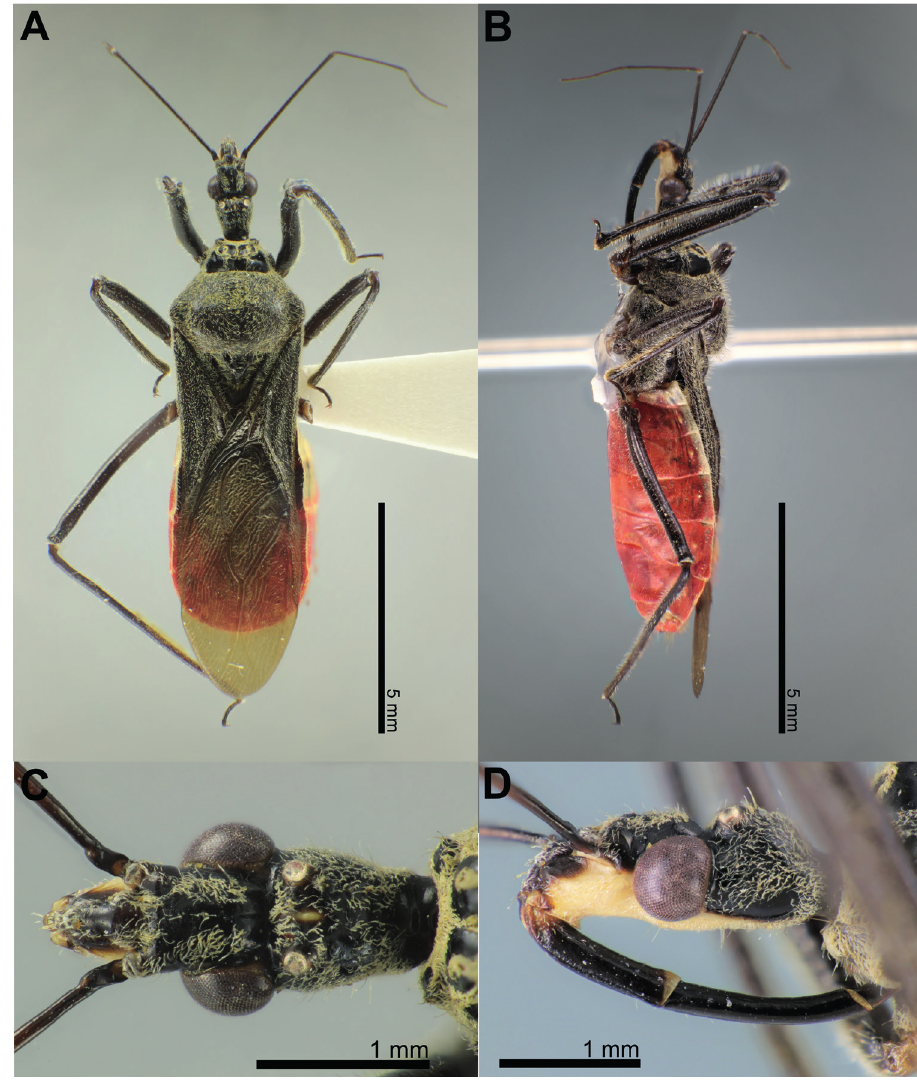
Figure 13. Biasticus taynguyenensis Ha, Truong & Ishikawa, sp. nov., holotype, ♀ , HNL2018-073 A body in dorsal view B body in lateral view C head in dorsal view D head in lateral